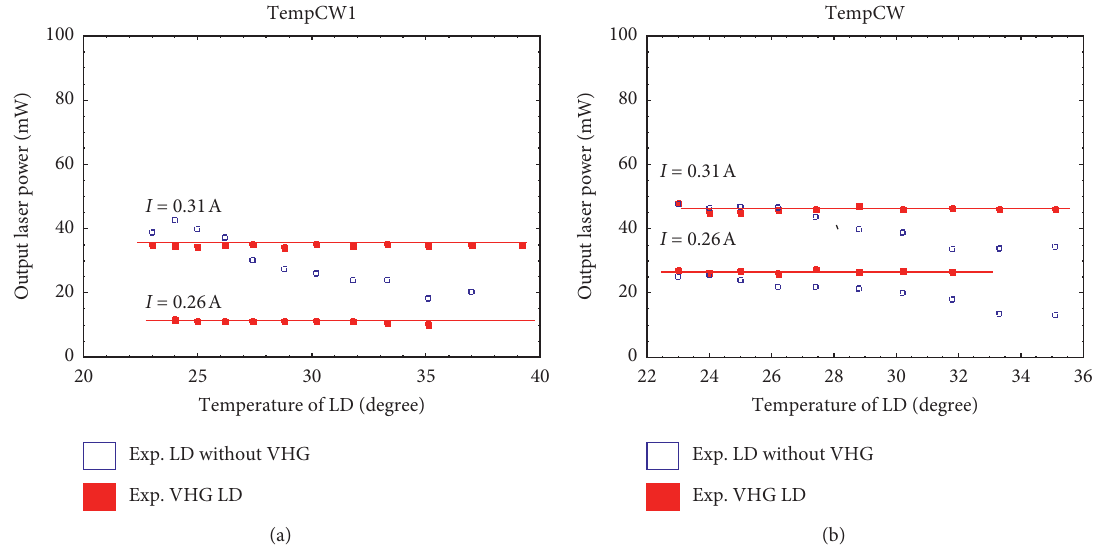
Figure 5: Stability of output laser power for LD temperature: (a) Nd:YAG and (b) Nd:YVO